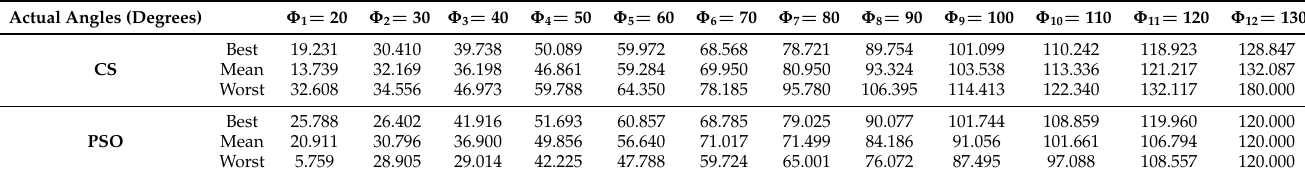
Table 9. Calculation of accuracy for twelve targets at − 10 dB